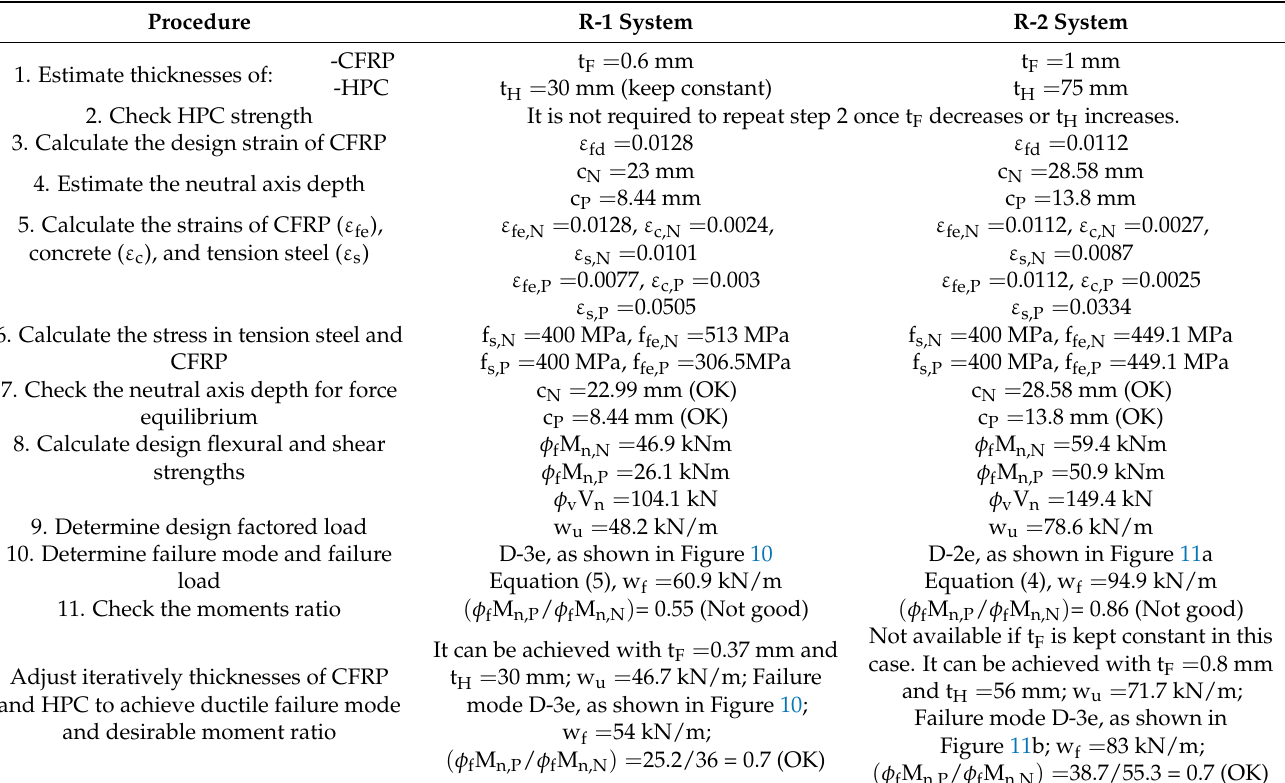
Table 6. Analysis to optimize the retrofit